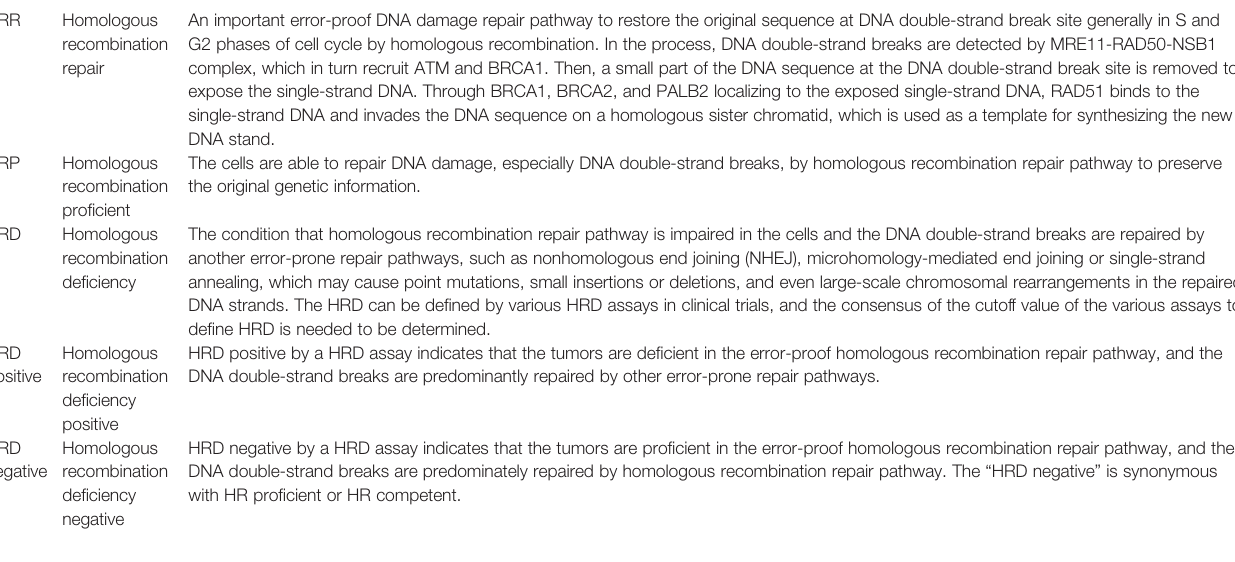
TABLE 1 | Terminology of homologous